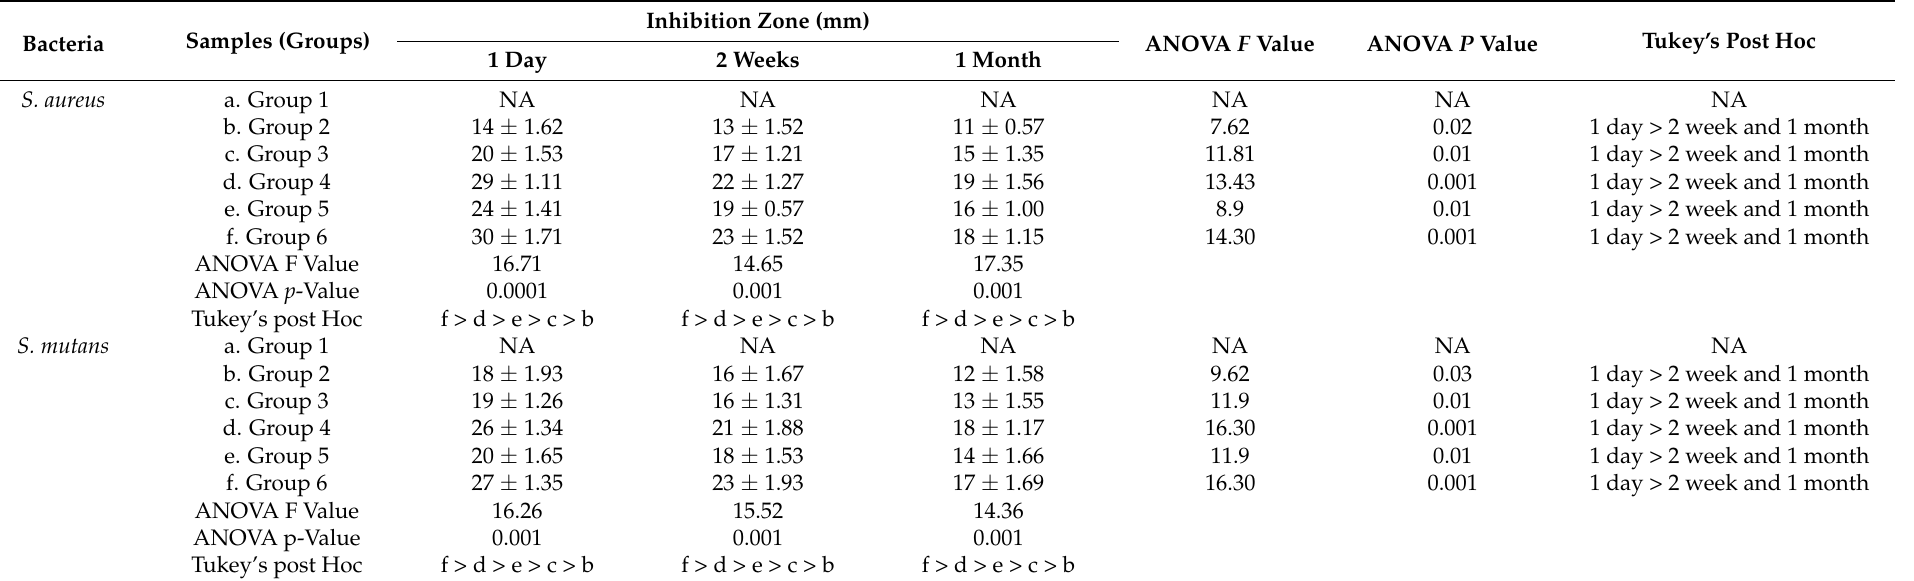
Table 3. Antimicrobial efficiency of modified dental luting cements against the tested